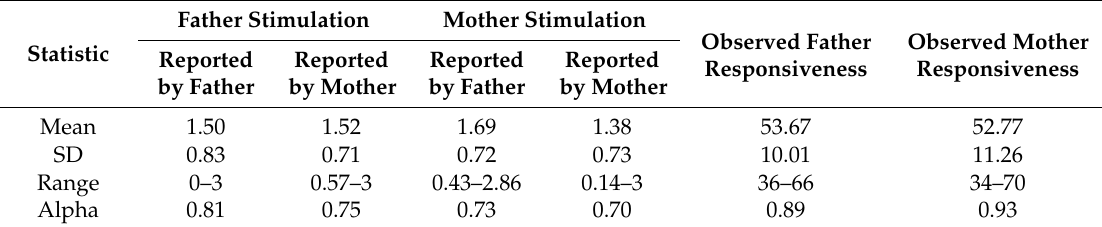
Table 1. Descriptive statistics for reported measures of paternal and maternal stimulation and observed measures of paternal and maternal